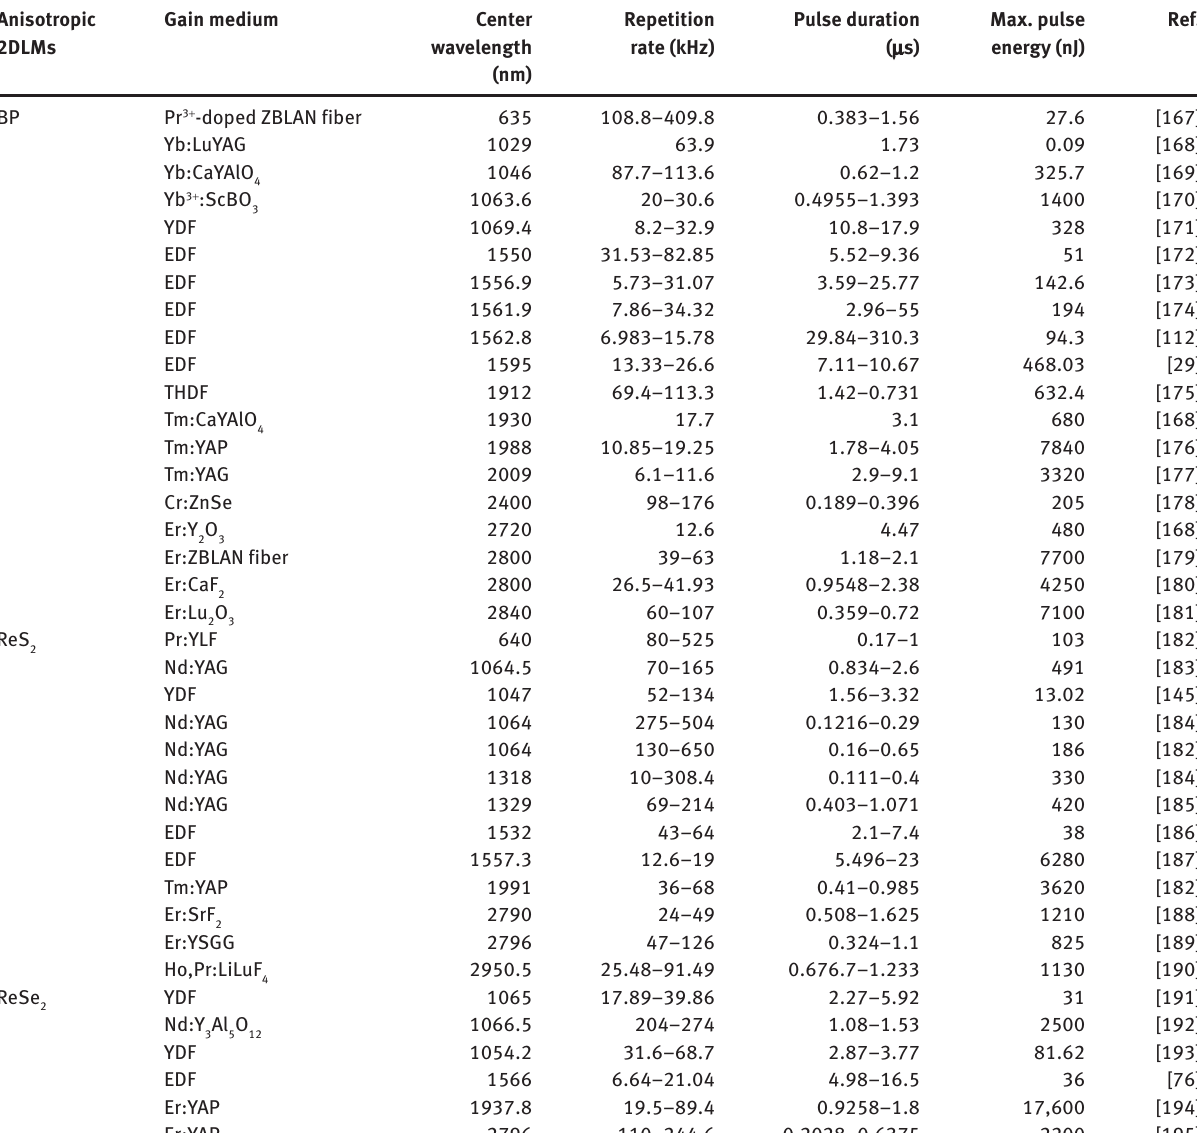
Table 2: Summary of Q-switched lasers with anisotropic 2DLMs. Anisotropic